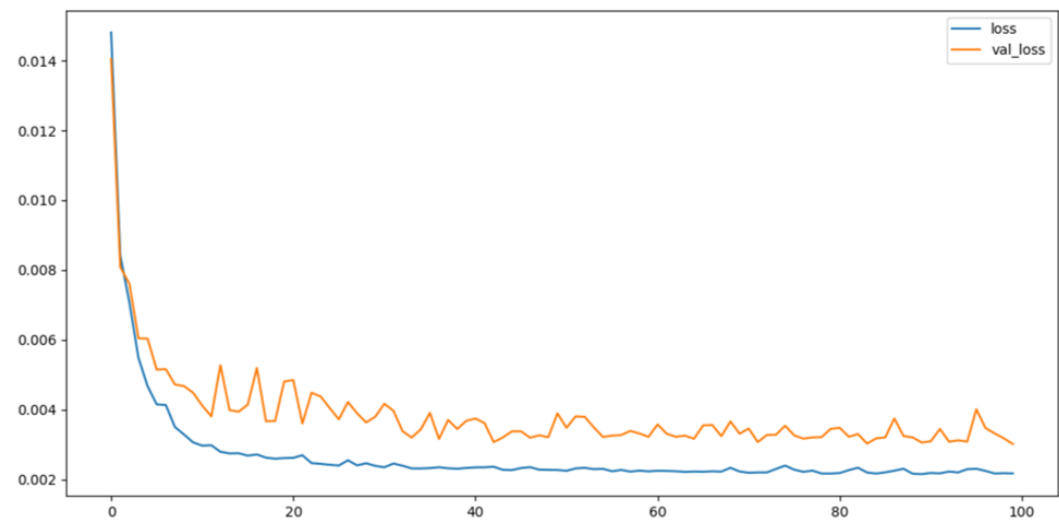
Figure 11. Structural diagram of TCN-LSTM model.